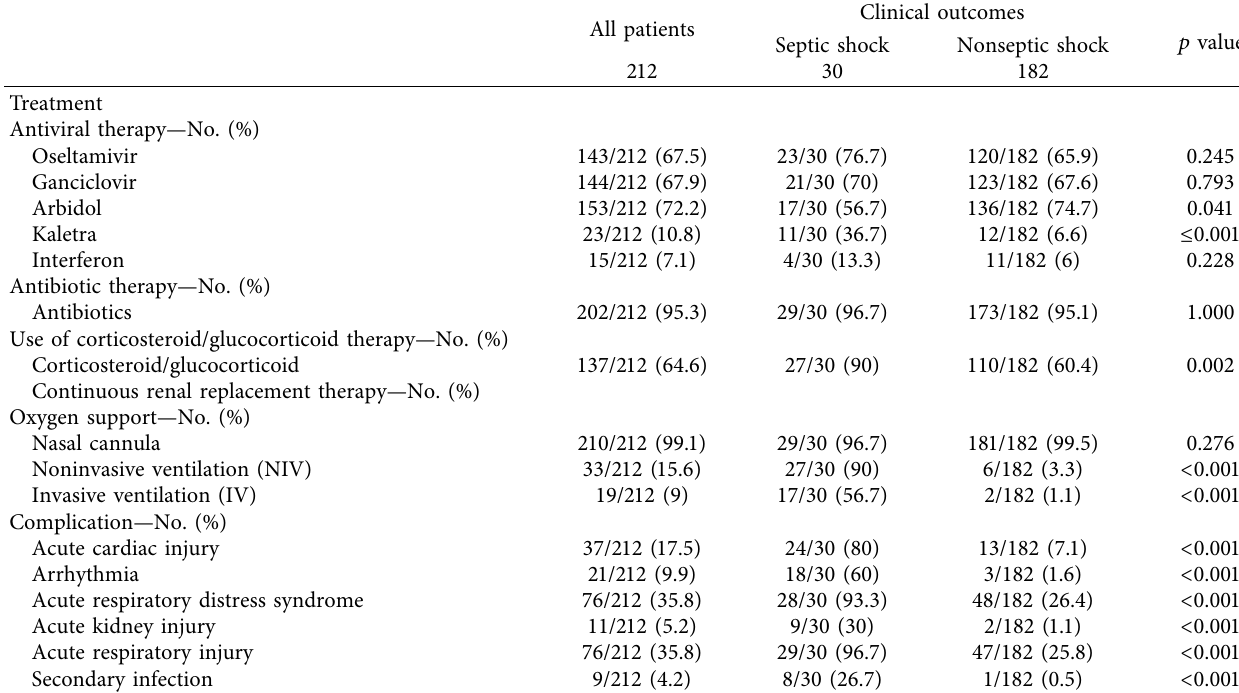
Table 3: Treatments, complications, and clinical